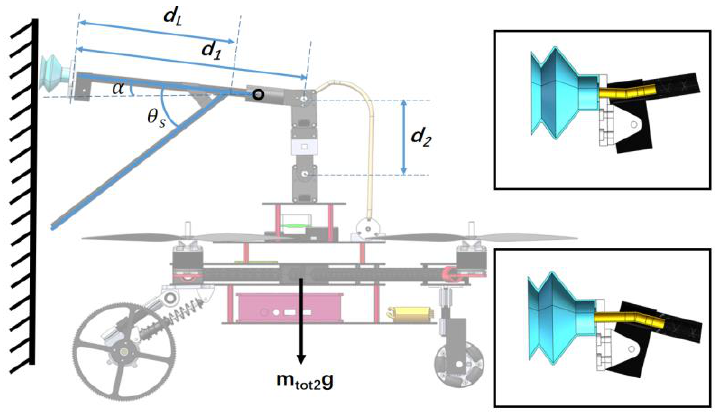
Figure 7. Structure of the suction cup and the support bars.